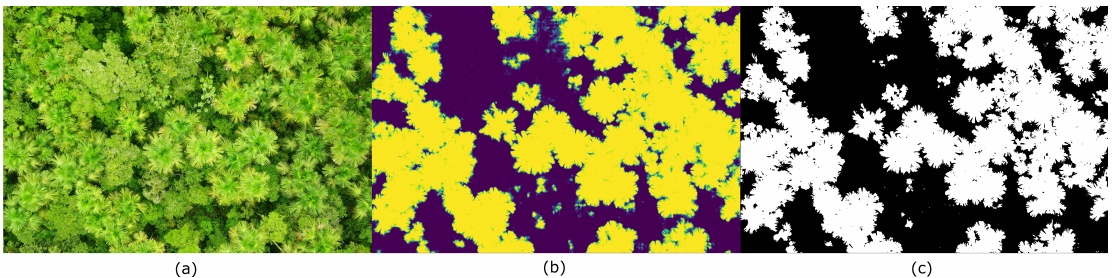
Figure 11. Mauritia flexuosa segmentation result for a whole image. ( a ) Original image. ( b ) Mauritia flexuosa probability map. ( c ) Mauritia flexuosa binary mask.